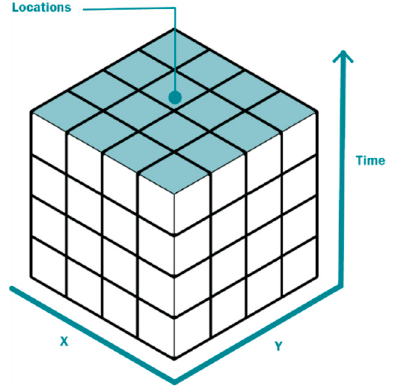
Figure 16. The space time cube concept